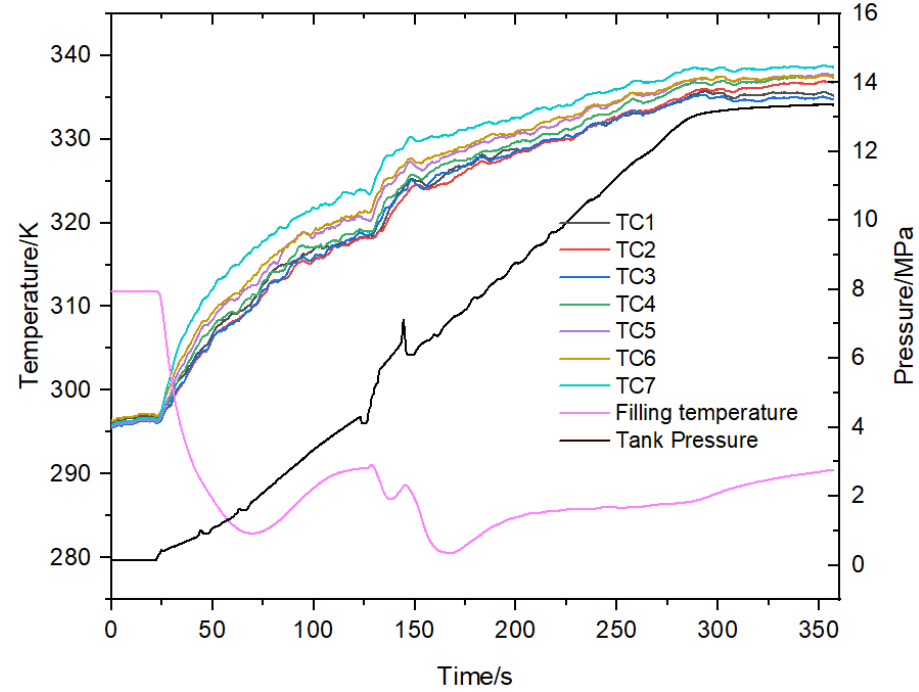
Figure 3. Measured temperature evolution during the air filling process.